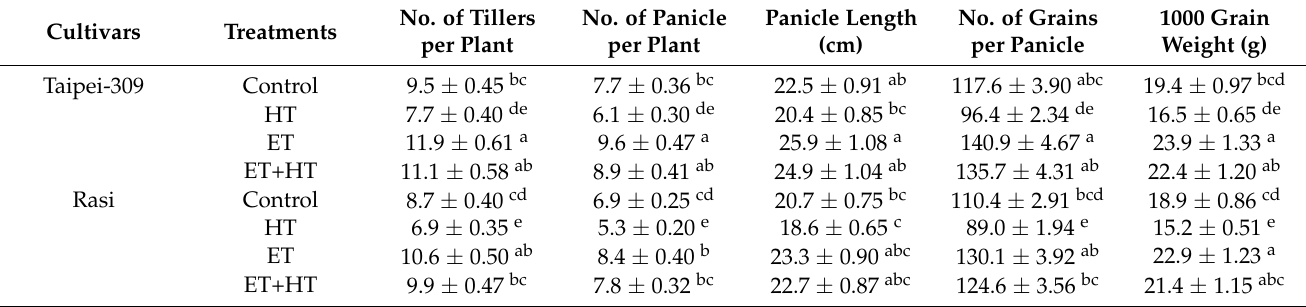
Table 5. Number of tillers per plant, number of panicles per plant, panicle length, number of grains per panicle, and 1000 grain weight in Taipei-309 and Rasi cultivars in rice ( Oryza sativa L.) at harvest. Plants were grown with/without high-temperature (HT) stress and treated with a foliar spray of 1.6 mM ethephon (ET) at 15 DAS. Data are presented as treatment means ± SE ( n = 4). The values followed by the same letters did not differ significantly by theLSD test at p < 0.05. DAS, days after